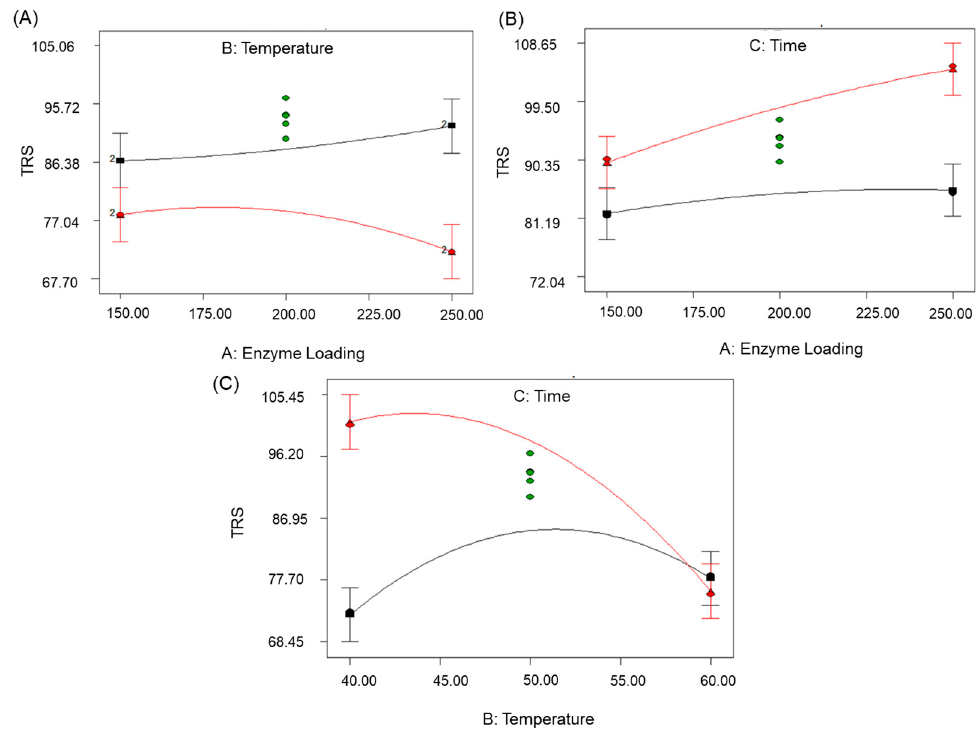
Figure 2. Interaction of ( A ) enzyme loading and temperature at 48-h hydrolysis time, ( B ) enzyme loading and hydrolysis time at 50 °C, and ( C ) hydrolysis time and temperature using 200 µg/mL enzyme.